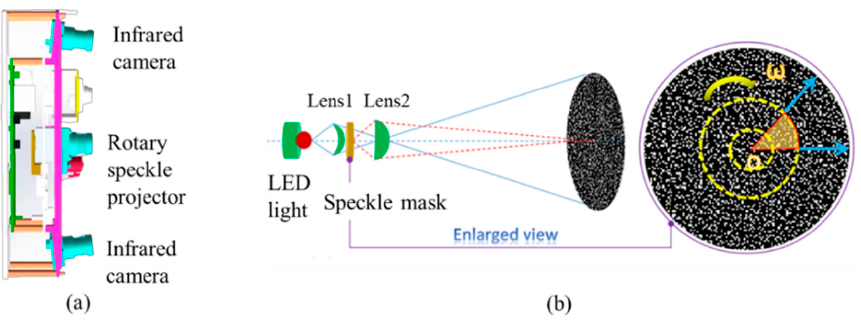
Figure 2. Schematic diagram of 3-dimensional face acquisition device with rotary speckle projector: ( a ) structure map of the device; ( b ) internal structure of the rotary speckle projector, where the speckle mask rotates at angular velocity ω